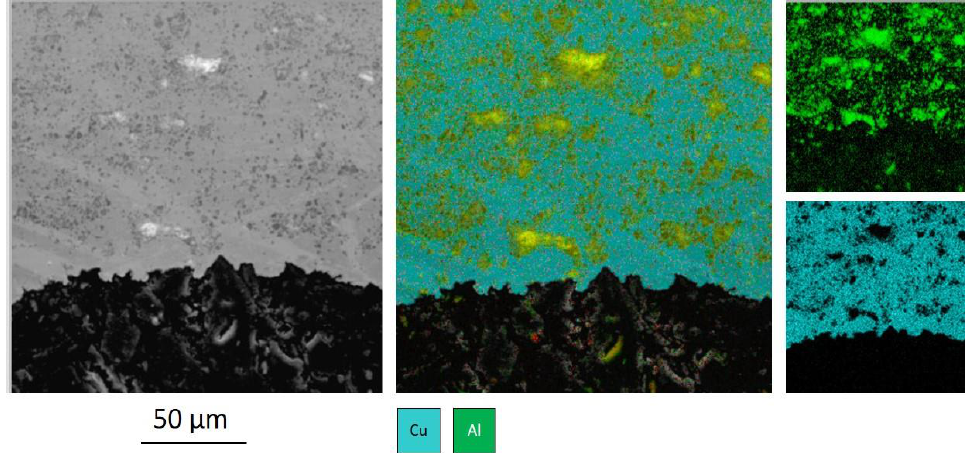
Figure 11. The microstructure and distribution maps of elements of the detached cold-sprayed